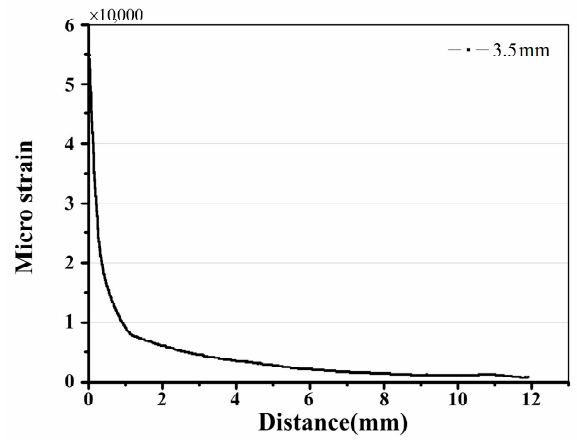
Figure 11. The cubic distribution along the axis of the FBG.